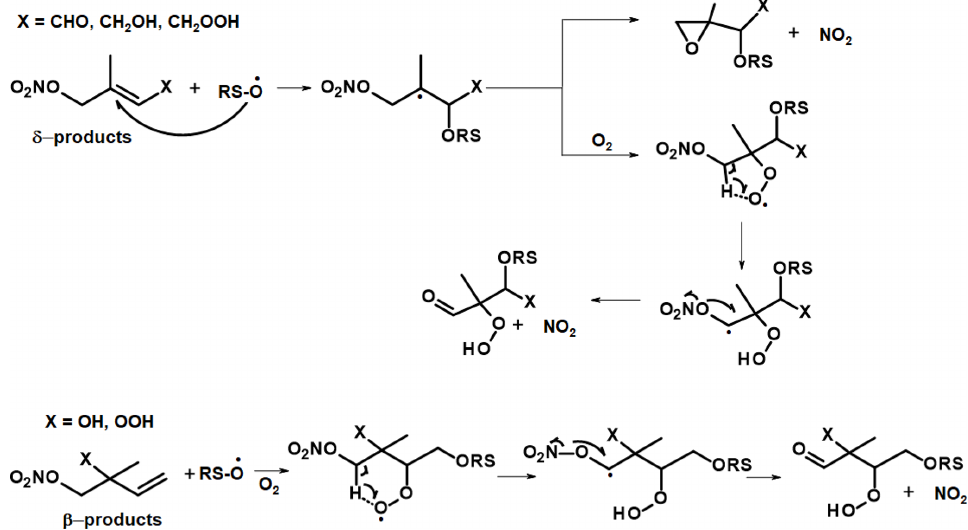
Figure 9. Possible mechanism for surface-catalysed conversion of first-generation ISOP-NIT in TDI-1. RS-O represents a reactive surface site.